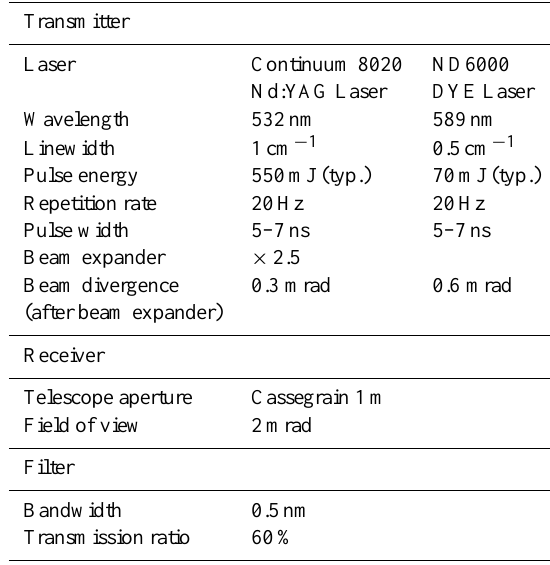
Table 1. Lidar parameters related to Na resonance fluorescence de-